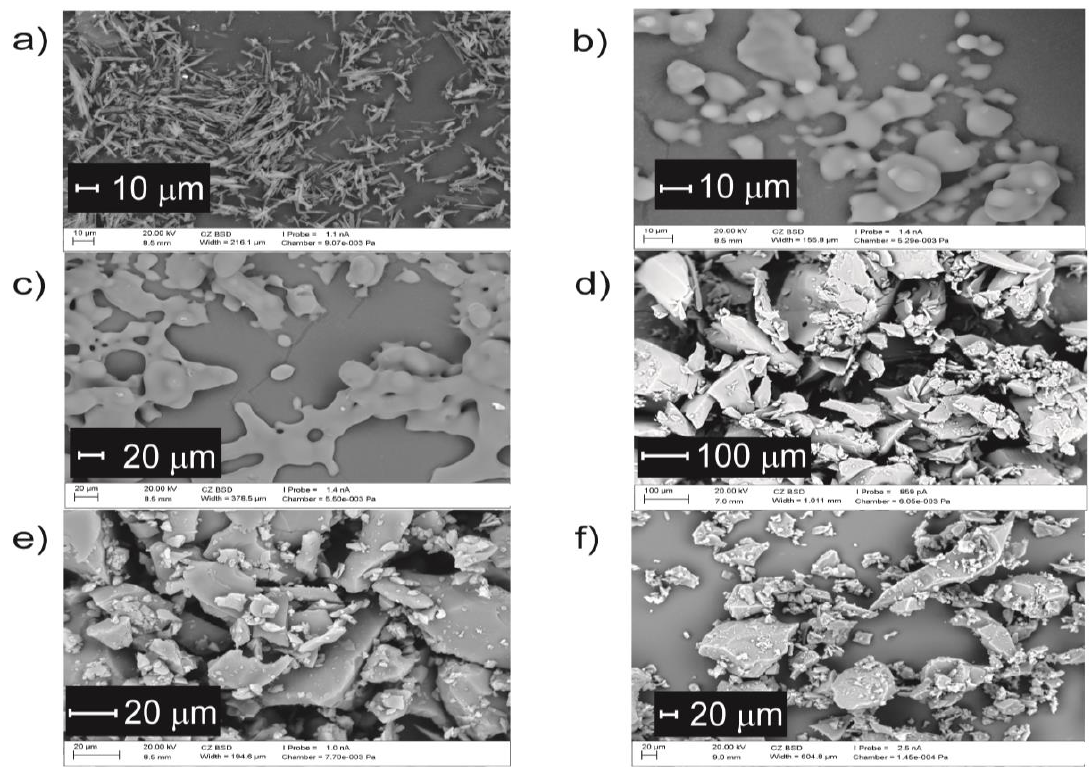
Figure 8. Imatinib mesylate (IM) microscopic images ( a ) crystalline form (magnification 1390x); amorphous form after ( b ) 2 weeks (magnification 1930x), ( c ) 1 month (magnification 794x), ( d ) 3 months (magnification 297x), ( e ) 6 months (magnification 1540x), and ( f ) 15 months of storage (magnification